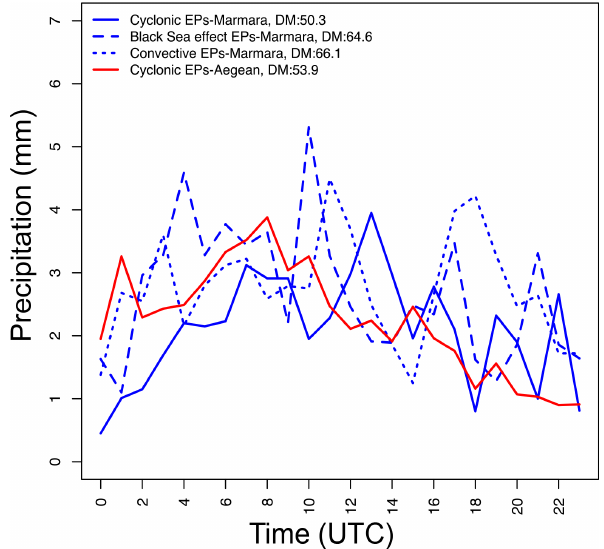
Figure 10. Average hourly precipitation amounts (mm) of EP days according to cyclonic, Black Sea effect, and convective types in Marmara for autumn and cyclonic EPEs for the Aegean in winter. DM indicates the daily mean precipitation amounts (mm) associated with the count of days that ended up with extreme precipitation. Table 3. Daily mean temperature and extreme hourly precipitation records and their temporal correlations during the 10 convective ex- treme precipitation days in the southern (Bursa) and eastern (Ko- caeli) stations. The bold value indicates the statistical significance at the 95% confidence level according to Student’s t